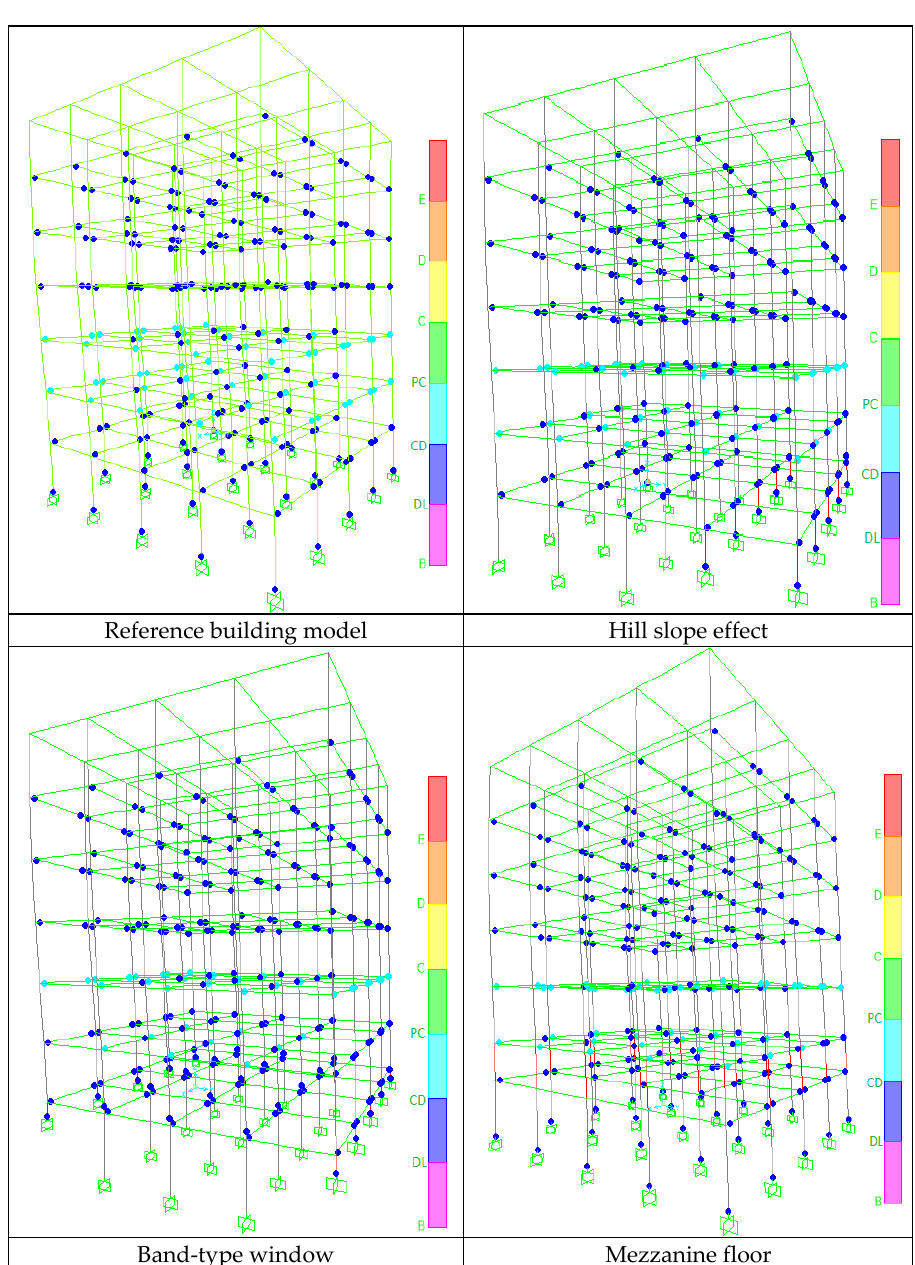
Figure 15. Damages in the structural elements. In all models, the columns remained in the zone of either obvious damage or damage limitation zone. The number of columns remaining in the obvious and damage limitation zone for the first and second floors of each structural model is given in Figure 16.